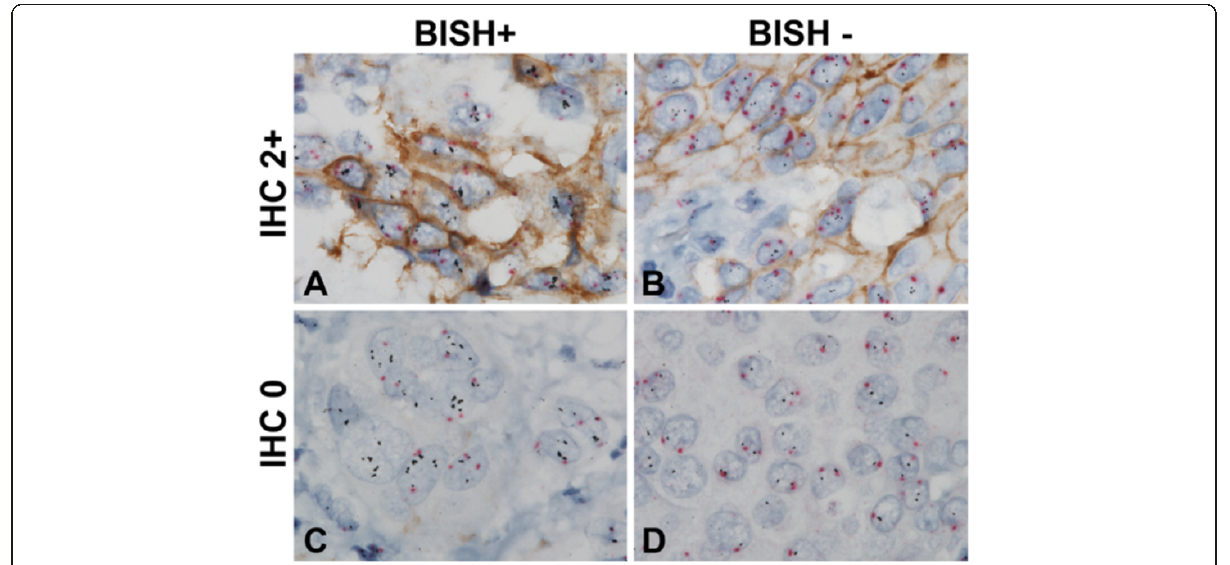
Figure 4 Differentiation of HER2 gene status in HER2 protein equivocal (IHC 2+) or negative (IHC 0) breast cancer tissues using the HER2 gene-protein assay. The HER2 gene-protein assay carried out on FFPE breast cancer tissue microarray slides was able to differentiate HER2 IHC 2+ cases that were HER2 & CEN17 BISH positive ( A ) and negative ( B ). It also distinguished HER2 IHC 0 cases that were HER2 & CEN17 BISH positive ( C ) and negative ( D ). [All images 100 ×